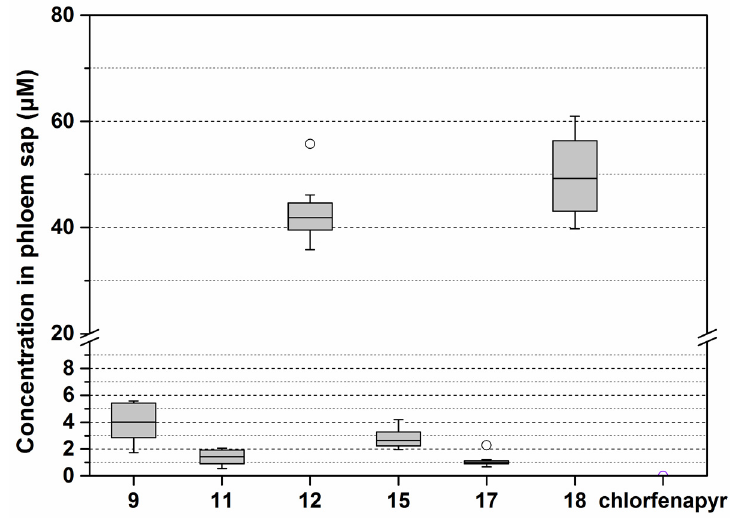
Figure 2. Phloem mobility of 9 , 11 , 12 , 15 , 17 , 18 and chlorfenapyr. The cotyledons were incubated in a buffered solution containing 200 µM 9 , 11 , 12 , 15 , 17 , 18 and chlorfenapyr at pH 5.5. The sap was collected at the third hour of incubation. For box plots, n = 8.